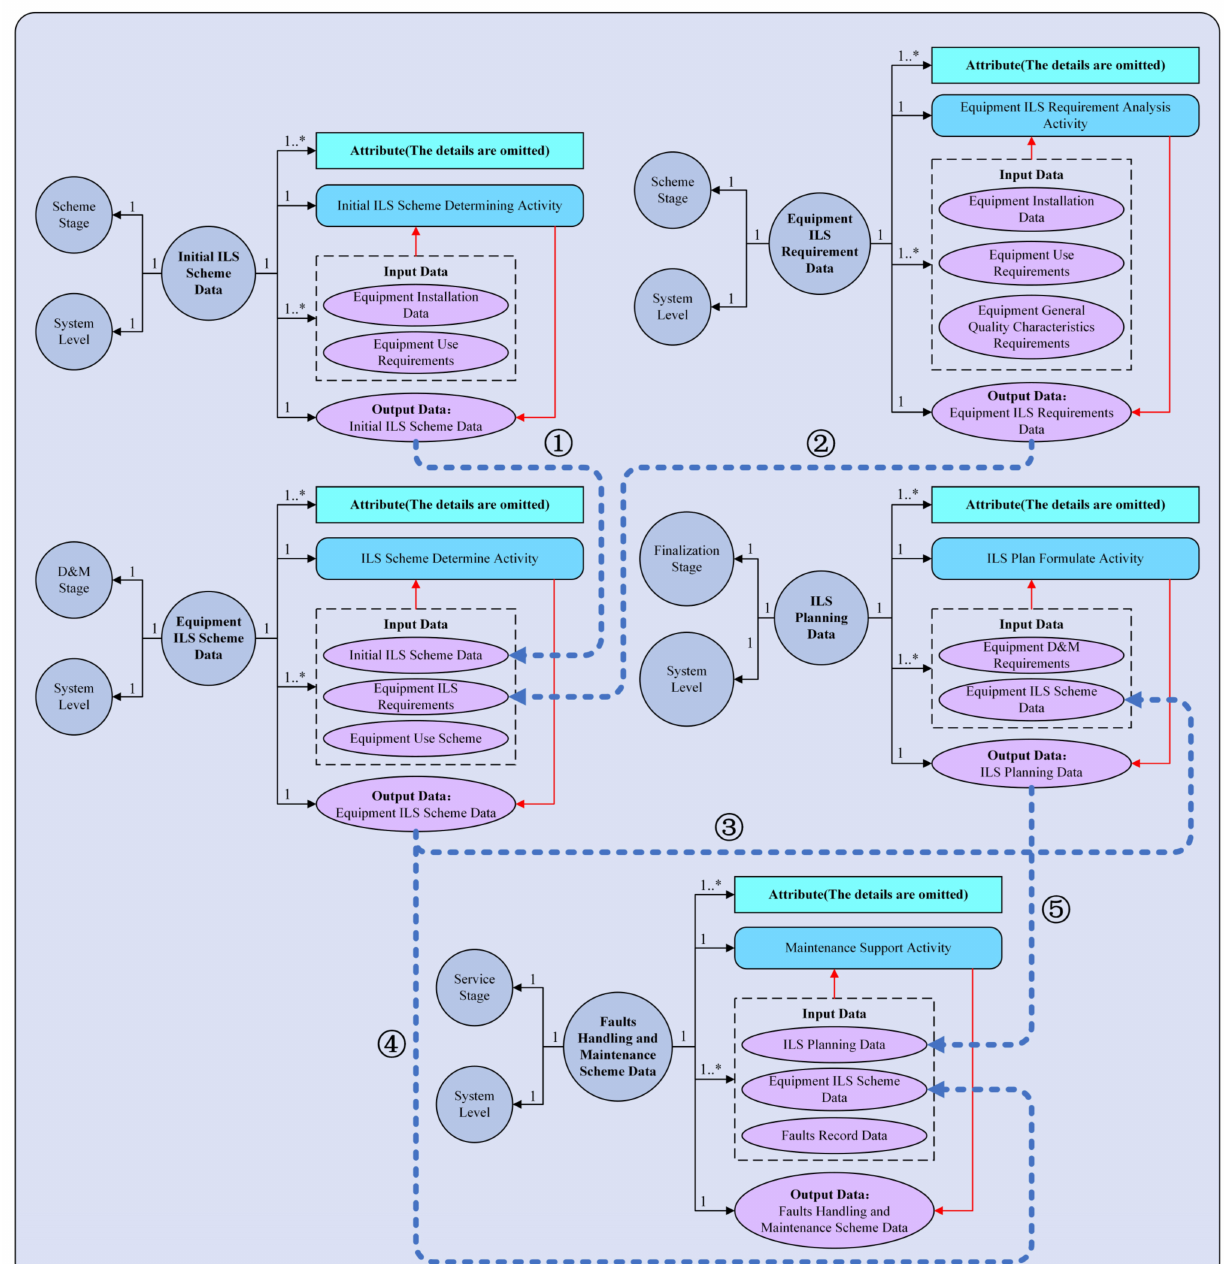
Figure 10. Lifecycle ILS unified data model framework. 1 (cid:13) means the Output Data of initial ILS schema data are the Iutput Data of equipment ILS schema data; 2 (cid:13) means the Output Data of equipment ILS requirement data are the Iutput Data of equipment ILS schema data; 3 (cid:13) means the Output Data of equipment ILS schema data are the Iutput Data of ILS planning data; 4 (cid:13) means the Output Data of equipment ILS schema data are the Iutput Data of faults handing and maintenance scheme